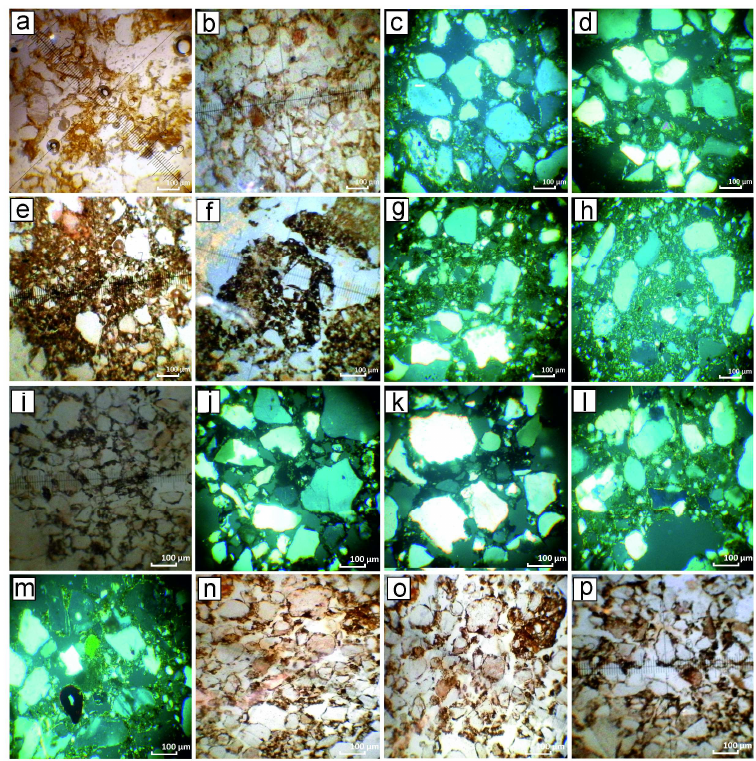
Figure 9. Kamyane-Zavallia 1. Soil micromorphology. ( a , b , e , f , i , n – p )—PPL, ( c , d , g , h , j – m )—XPL. Magnification 1:70. Elaboration—ZM. Magnification 1:70.